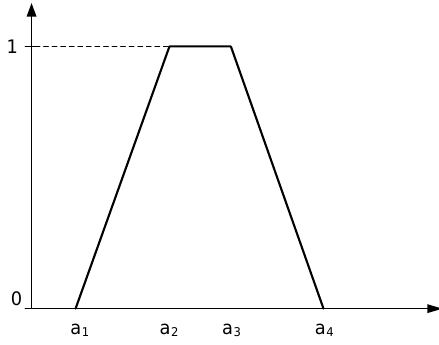
Figure 2. Trapezoidal number membership function.